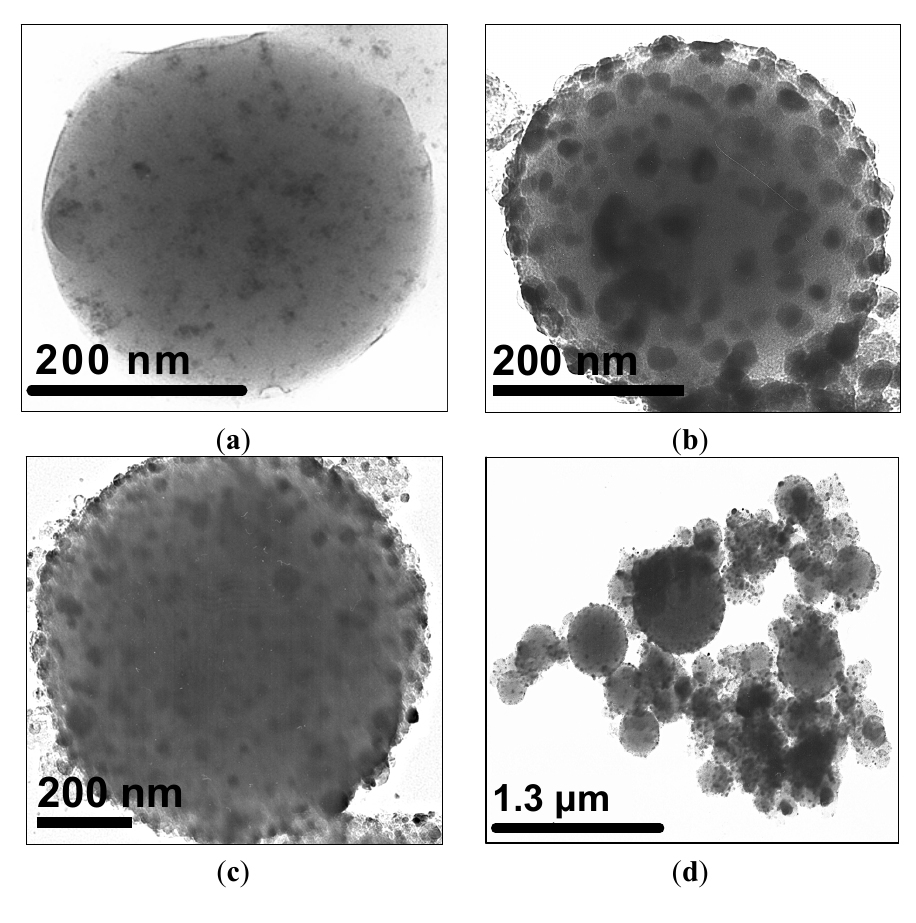
Figure 1. Transmission electron microscopy (TEM) images of: ( a ) NPGMSi-1; ( b ) NPGM-2; and ( c , d )